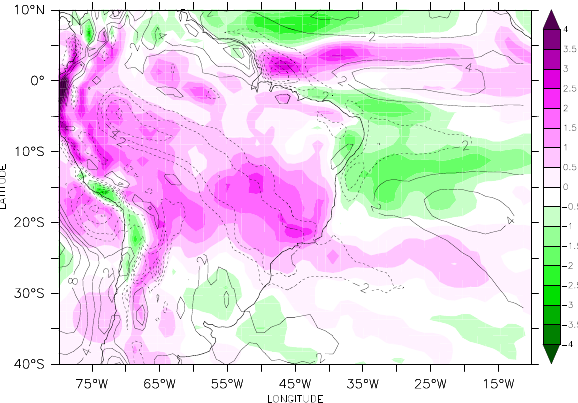
Fig. 14. MH - PI JFM difference in (a) vertical velocity at 500hPa in hPa/s, and (b) vertical velocities averaged over 70 ◦ W:10 ◦ W. Negative values indicate upward motion. Contours are PI JFM values.